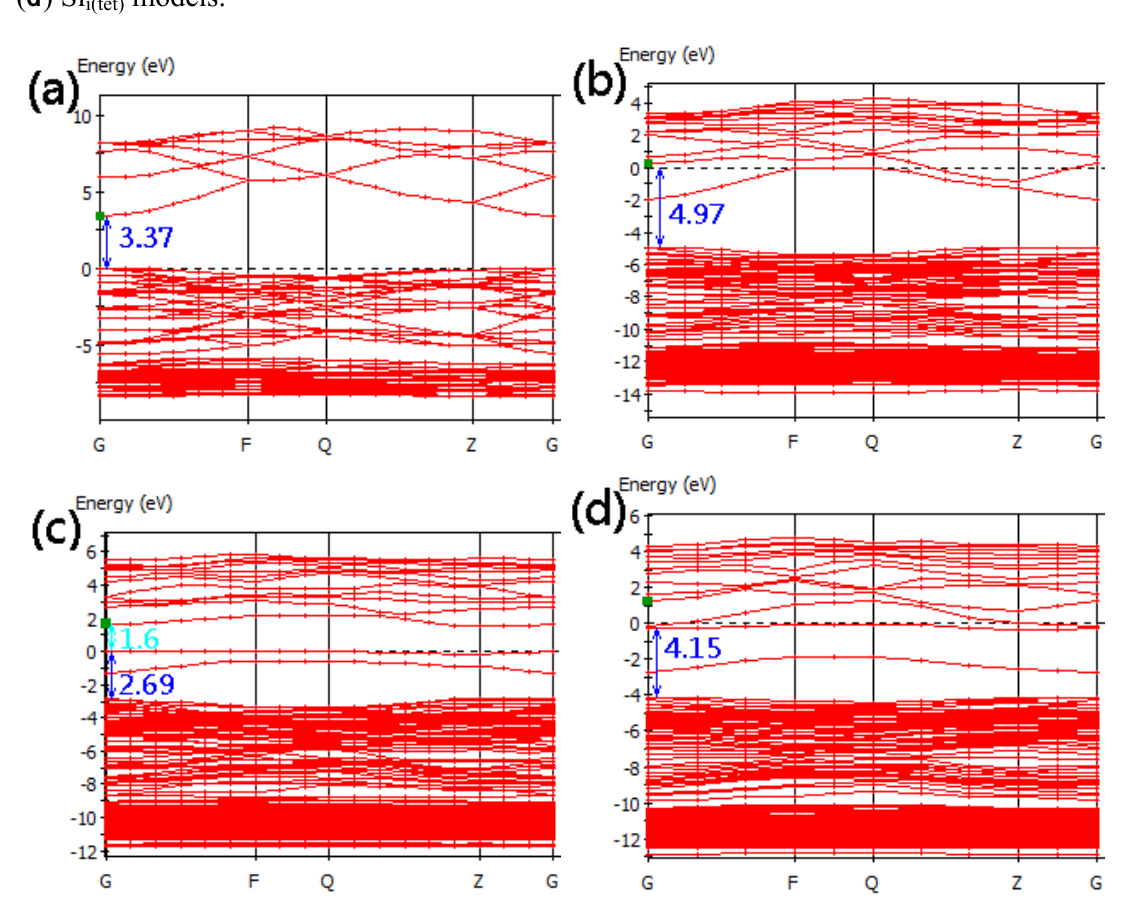
Figure 4. Band structures of Si-doped ZnO for ( a ) pure ZnO; ( b ) Si